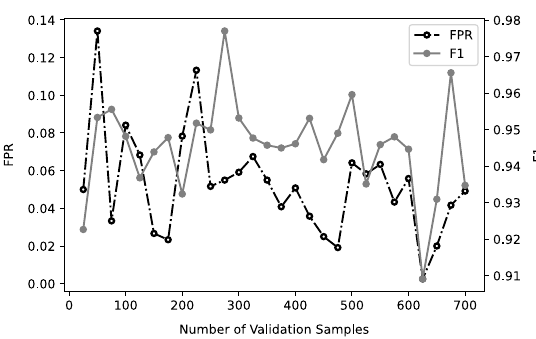
Fig. 7 FPR & F1 versus number of validation